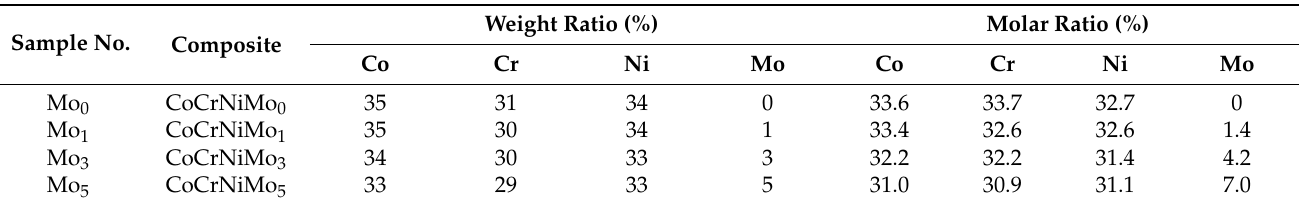
Table 1. Compositions of CoCrNiMo x alloy